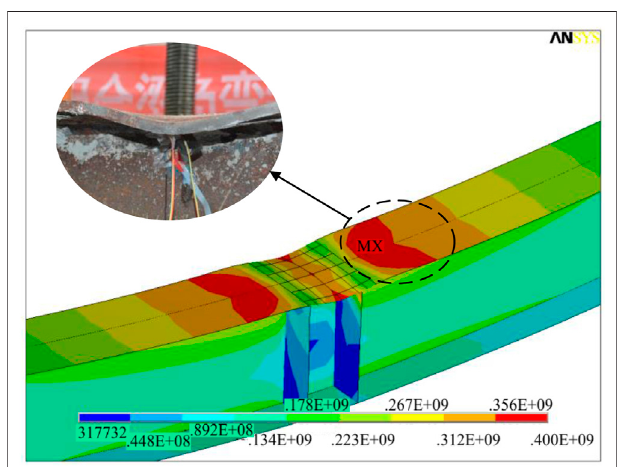
FIGURE 9 | Equivalent stress distribution at yield loading of the bottom fl ange plate (unit: Pa).